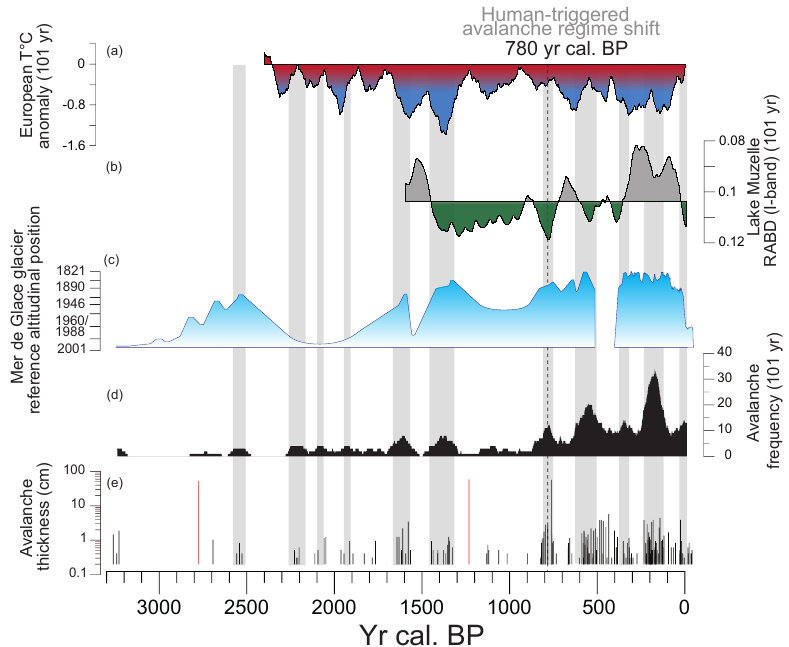
Figure 9. Lake Lauvitel avalanche record compared to climate parameters. (a) European temperature anomaly from Büntgen et al. (2011), (b) nearby Lake Muzelle glacier fluctuation (Fouinat et al., 2017b), (c) the Mer de Glace length record from Le Roy et al. (2015), (d) Lauvitel avalanche frequency on a 101-year average and (e) avalanche thickness